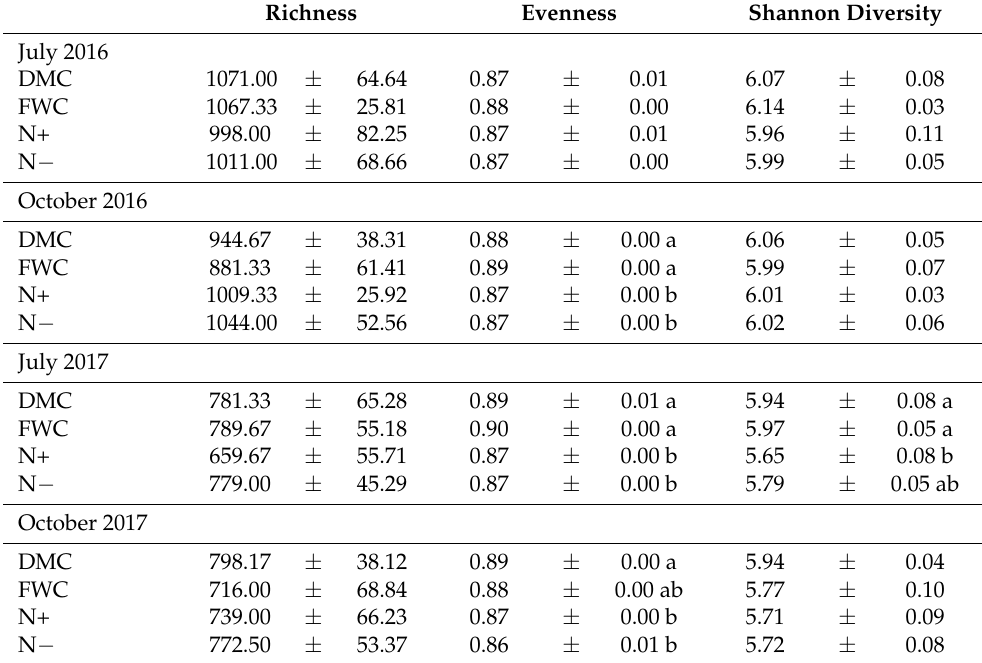
Table 2. Average bacterial and archaeal species richness, evenness and Shannon Diversity indices ± standard error of measurement (SEM) from an almond orchard receiving different or- ganic amendments. Letters denote statistical differences of p < 0.05 determined by either post hoc Tukey’s honestly significant difference (HSD) test or Dunn’s test, for non-normally distributed data. DMC = Dairy manure compost, FWC = Food waste compost, N+ = nitrogen fertilizer, N − = unamended control. Categories with 0 values indicate SEM under